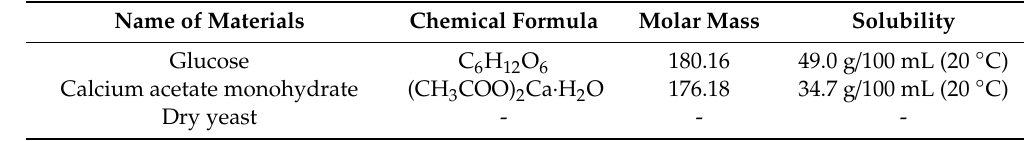
Table 1. Specifications of the basic constituent material.